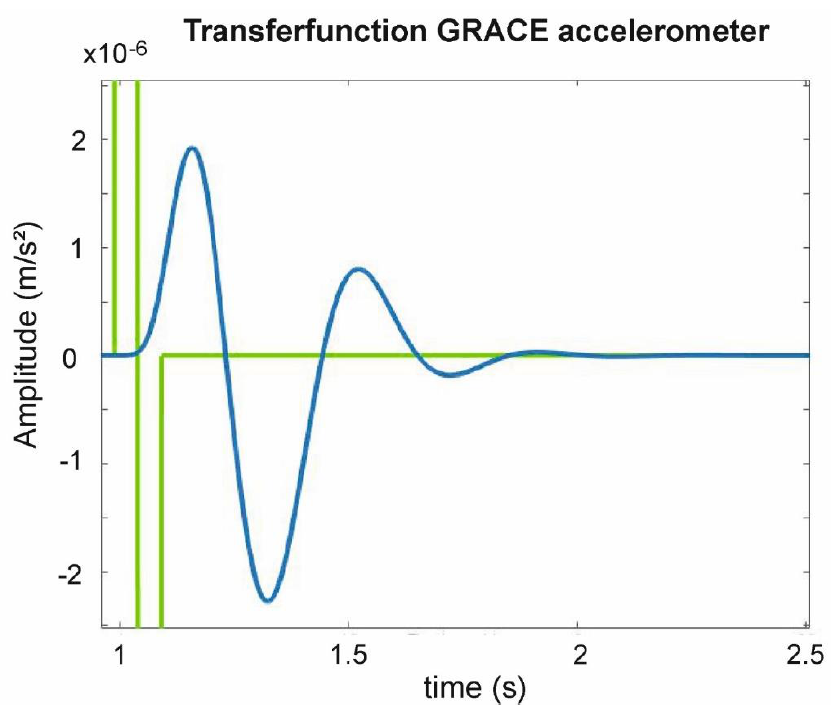
Figure 5. With the help of the transfer function (according to [19]) the response of the accelerometer to a rectangular up-and-down peak with 10 −5 m/s² and a duration of 20 ms can be calculated. The input acceleration is shown in green, and the response of the accelerometer is shown in blue.